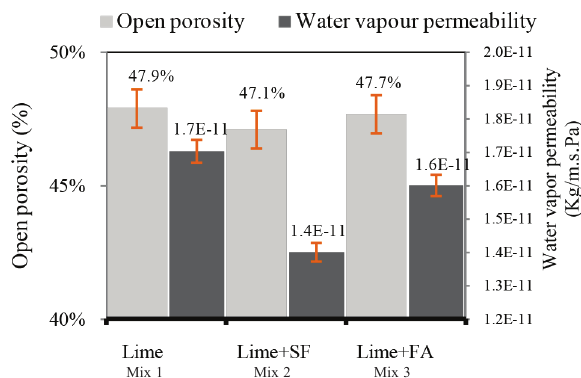
Fig. 9(a). Effect of pozzolans on water vapour permeability of grout